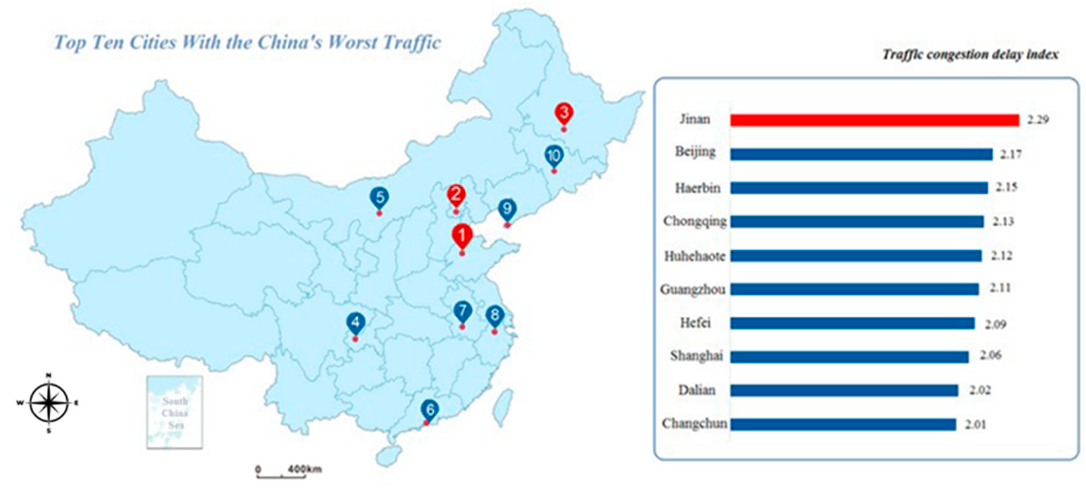
Figure 5. Traffic congestion rankings for Chinese cities in 2017 (GMTBDP, 2018).